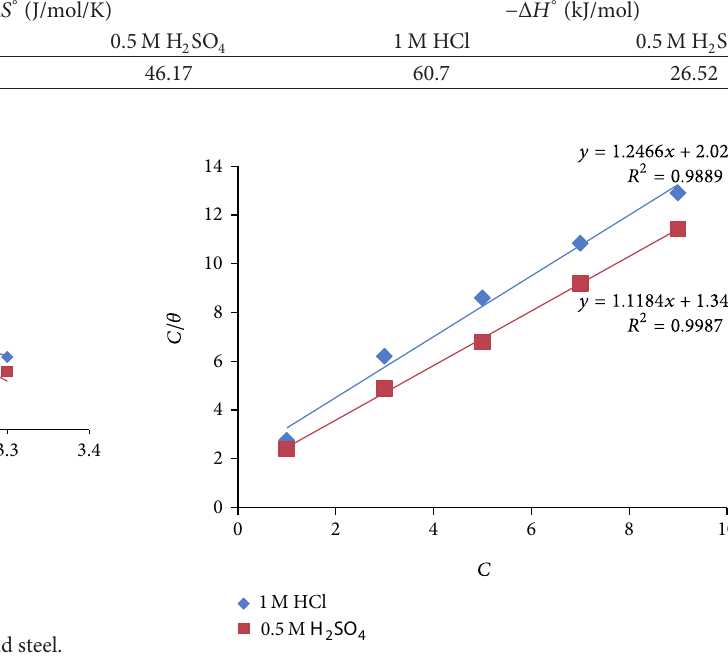
F 4: Langmuir adsorption isotherm for inhibitor in 1M HCl SO . and 0.5M H 2 4